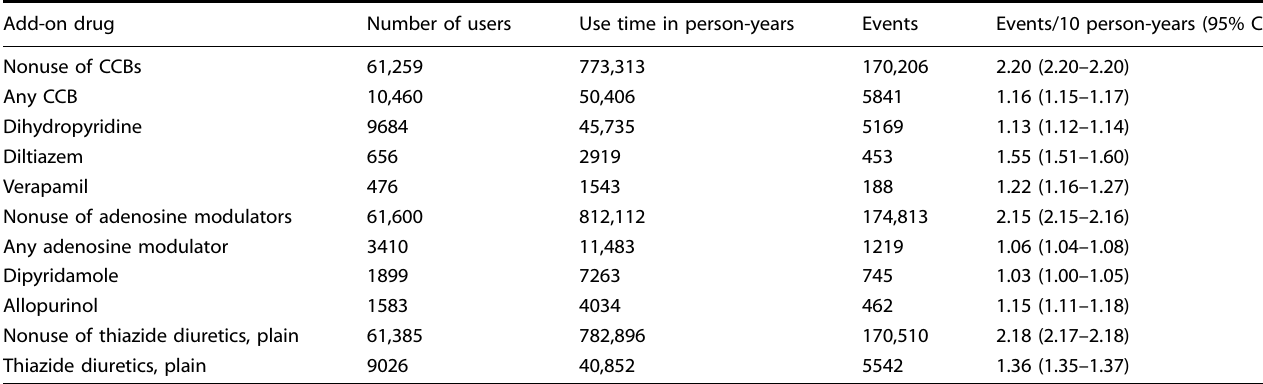
Table 2. Number of users, events, and incidence rates of psychiatric rehospitalizations during add-on drug use. Add-on drug